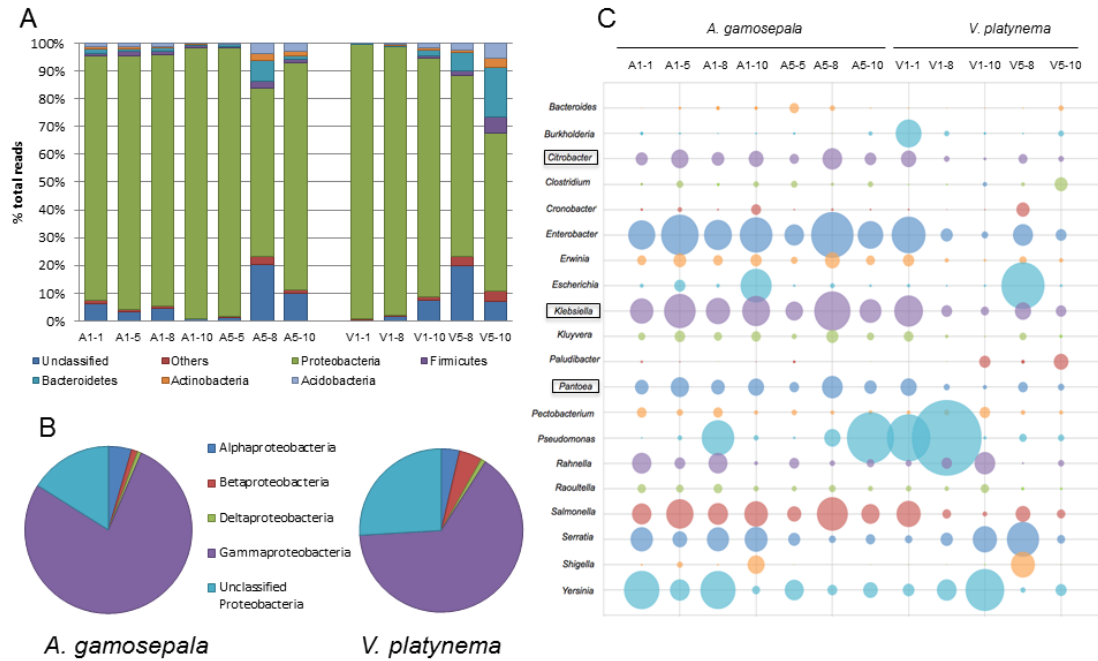
Figure 5. The relative abundance of prokaryotes present in Aechmea gamosepala and Vriesea platynema tank at frequencies higher than 1%. ( A ) Microbial abundance at phylum level for di ff erent specimens of A. gamosepala (A1 and A5) and V. platynema (V1 and V5) along the di ff erent seasons (numbered according to the month of sampling: 1—summer; 5—fall; 8—winter; 10—spring). ( B ) Average abundance of Proteobacteria classes in A. gamosepala and V. platynema . ( C ) Microbial abundance at genus level for the same samples depicted in (A). Boxes indicate genera with significant di ff erences ( p ≤ 0.05) in abundance between the bromeliad species.